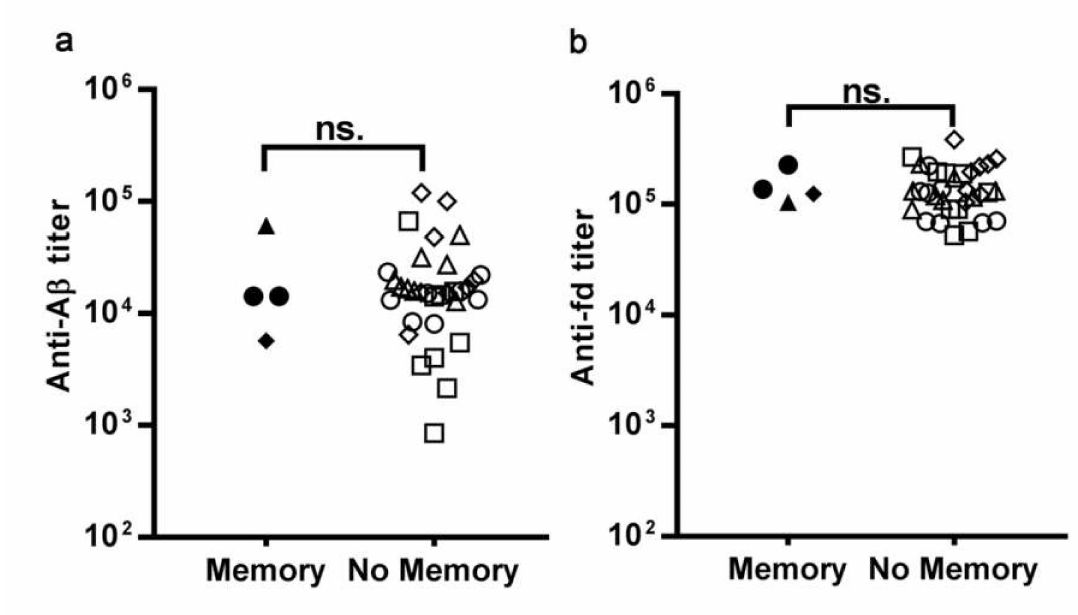
Figure 5. The dot plots show the IgG titer against A β ( a ) and fd ( b ) at day 273, the day before the recall dose, in mice that displayed an enhanced response (peak magnitude ratio over 2- Memory) and all other mice (peak magnitude ratio below or equal to 2- No Memory). Each dot represents a mouse of the control SD group (circles), D7B group (triangles), D15B group (squares), D21B group (diamonds). There is no statistically significant di ff erence ( p = 0.43, Mann Whitney test) in the pre-existing antibody titer against A β and fd at the time of recall between mice that did or did not display enhanced secondary responses (i.e., memory) to A β